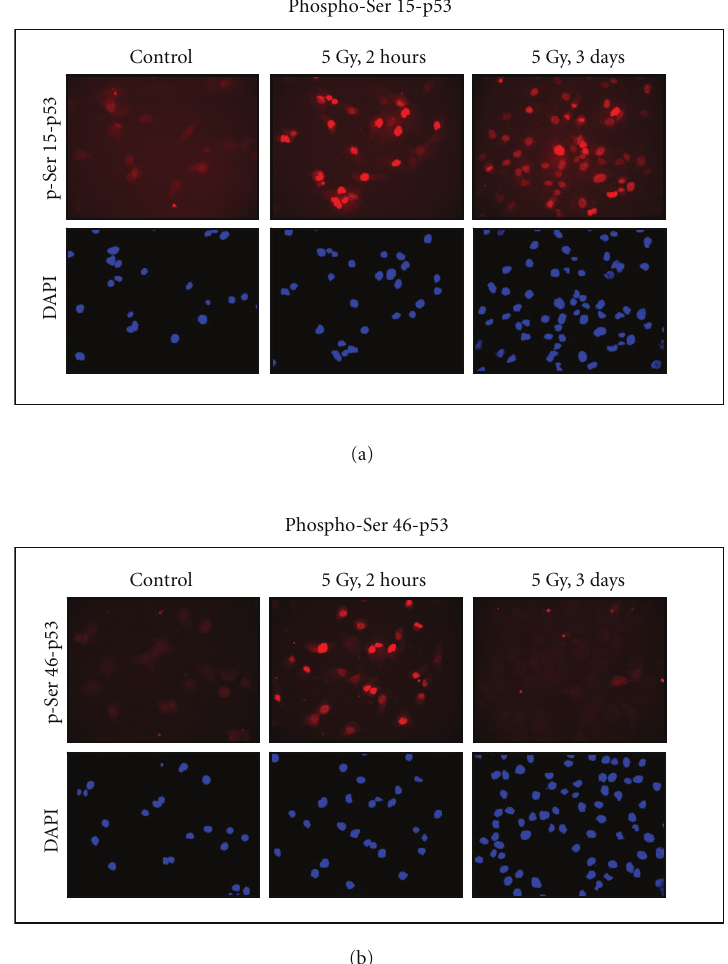
Figure 6: Immunofluorescence analysis of p53 phosphorylation (red) in A172 cells before and at indicated times after exposure to ionizing radiation (5Gy). These experiments were performed using our published techniques [18], except for the use of phosphospecific antibodies to Ser 15 (a) or Ser 46 (b) of p53 (Cell Signaling, Beverly, MA, USA). Nuclei were counterstained with DAPI